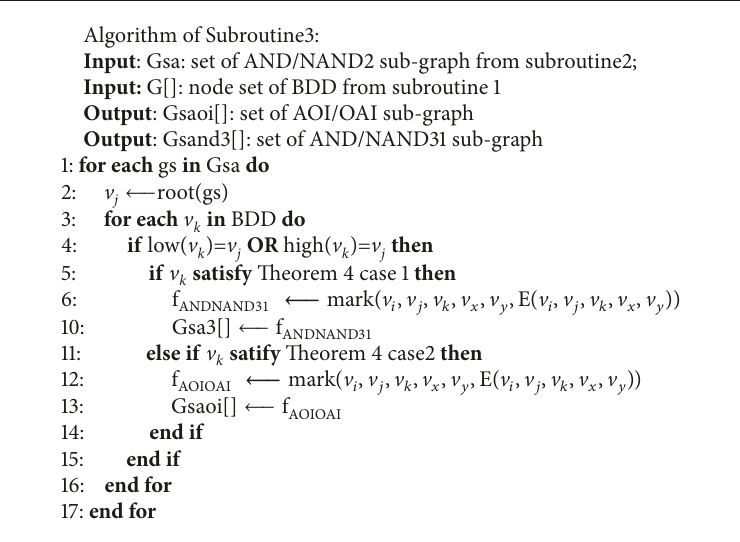
Algorithm 3: The algorithm of subroutine 3 in the BDD-based extraction